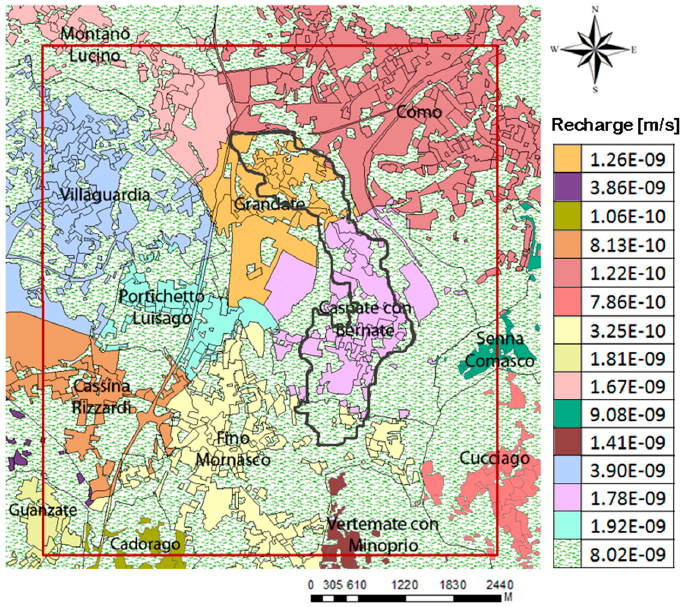
Figure 8. Urbanized (colored zones) and non-urbanized (dotted zones) areas in the model domain. The morainic arc in the right part of Grandate is contoured in black.